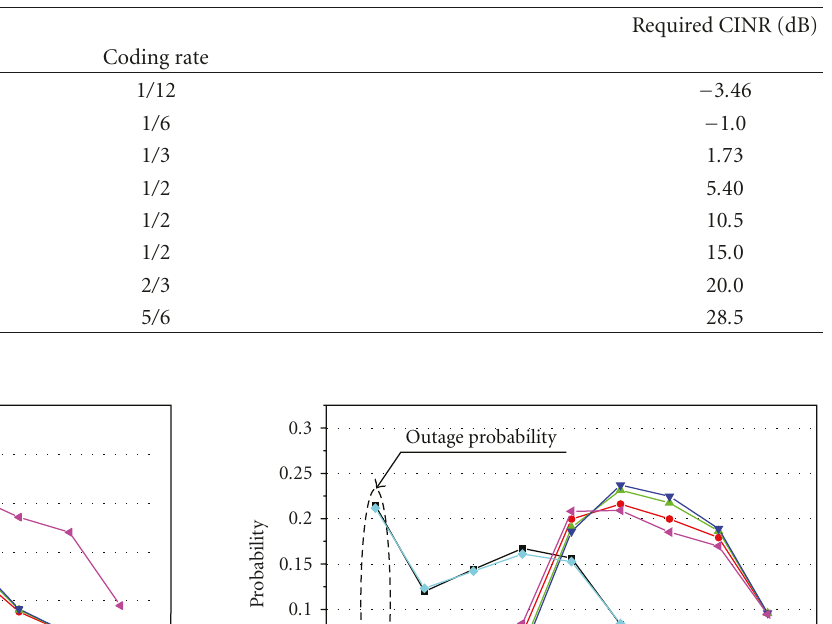
Table 1: MCS table for adaptive modulation and coding